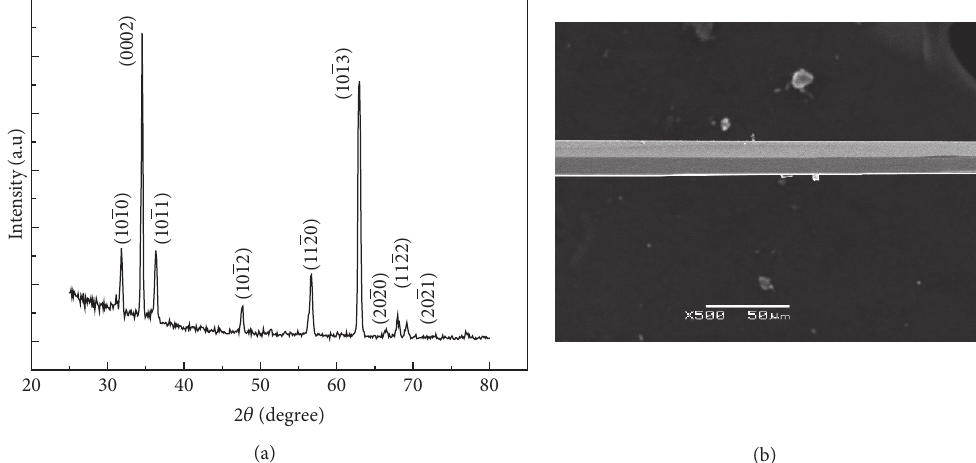
Figure 1: (a) The XRD pattern of the ZnO microrod and (b) the SEM image of the selected microrods for laser investigation.